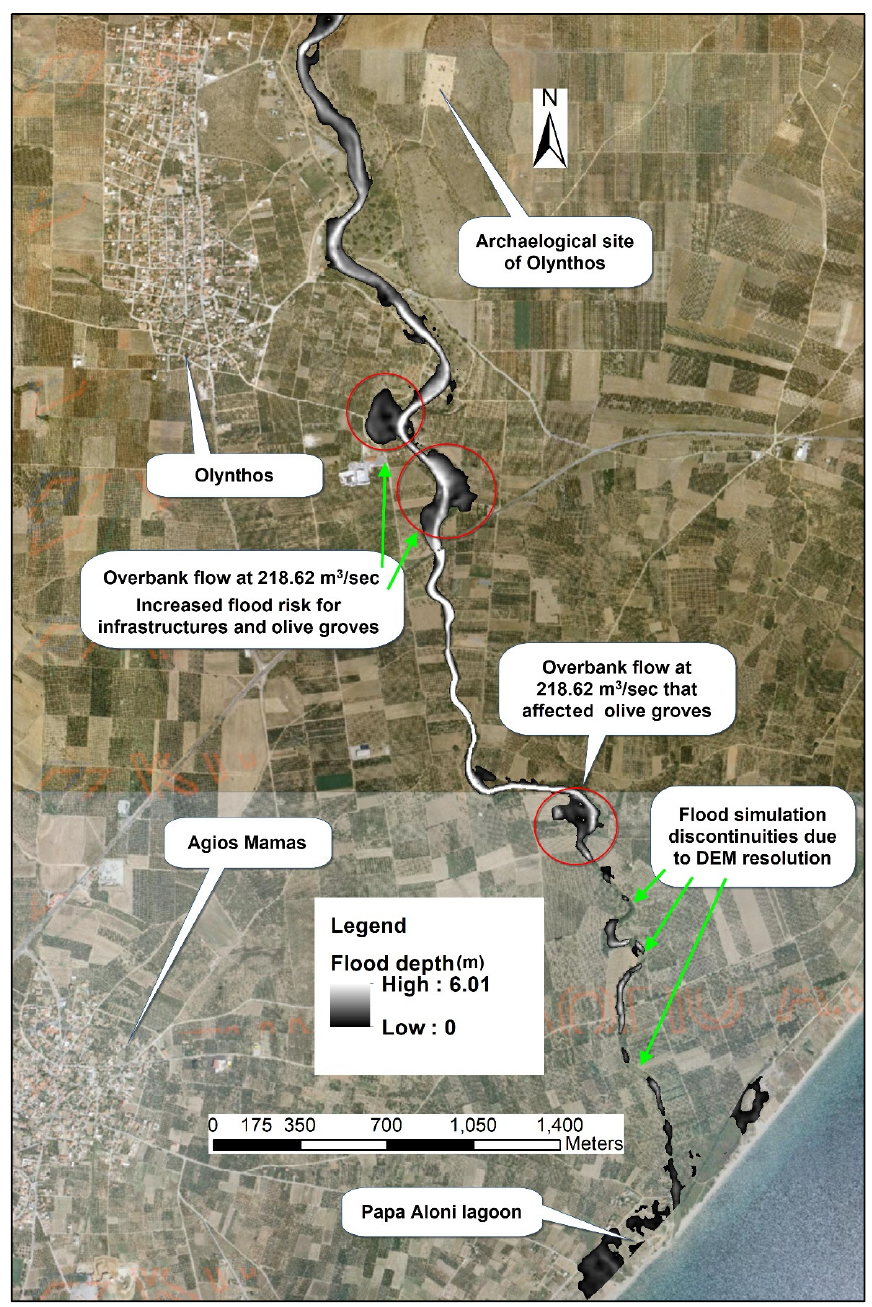
Figure 16. Simulation of the February 2010 flood event at the Vatonias stream.